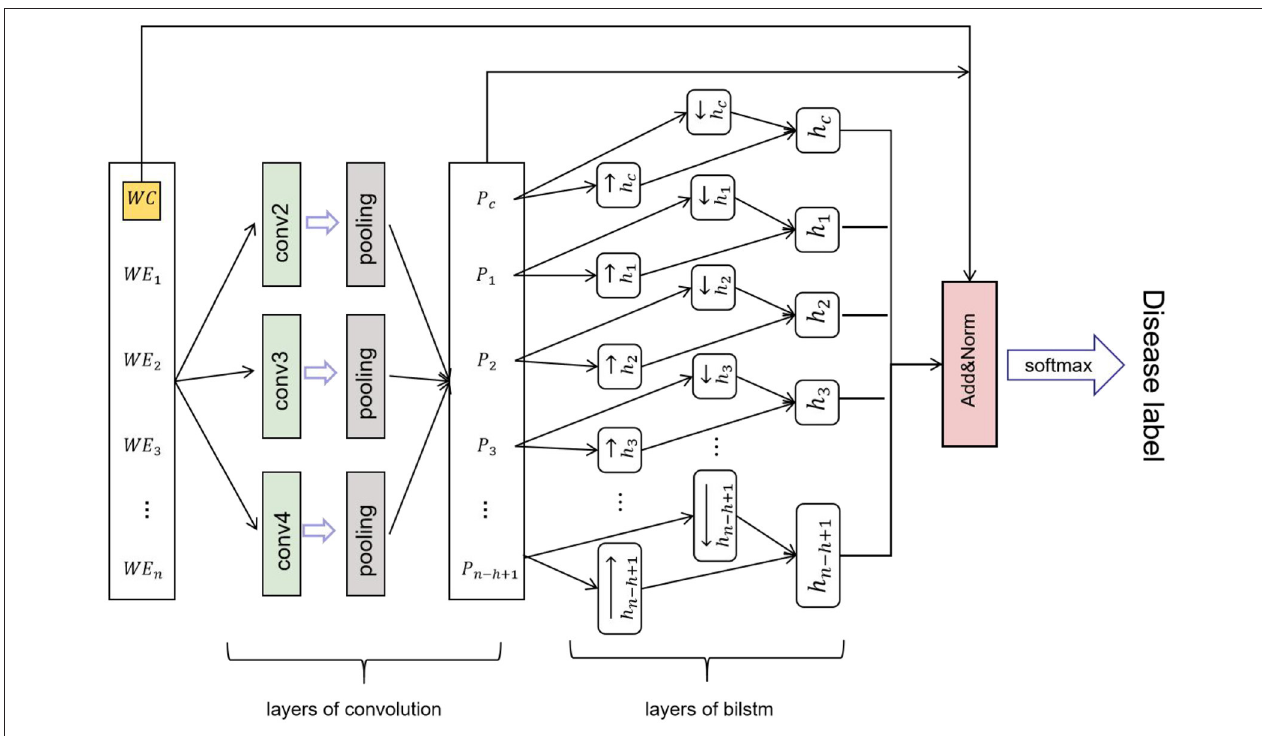
FIGURE 5 | Data feature exaction through CNN-BILSTM model.